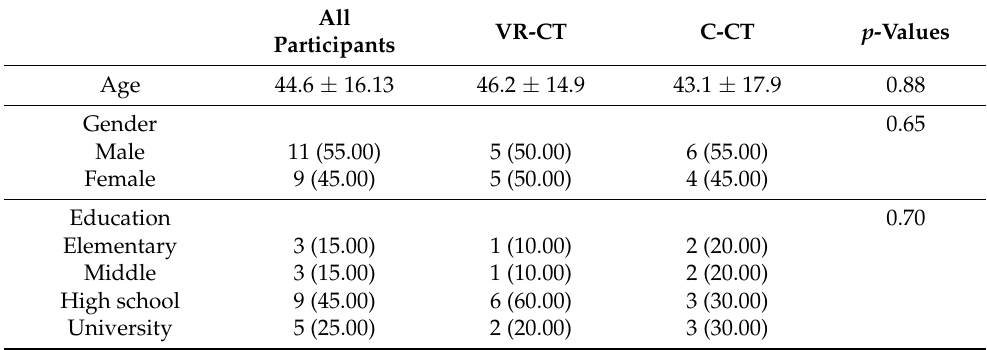
Table 1. Demographic and clinical description of the sample at the beginning of the study.